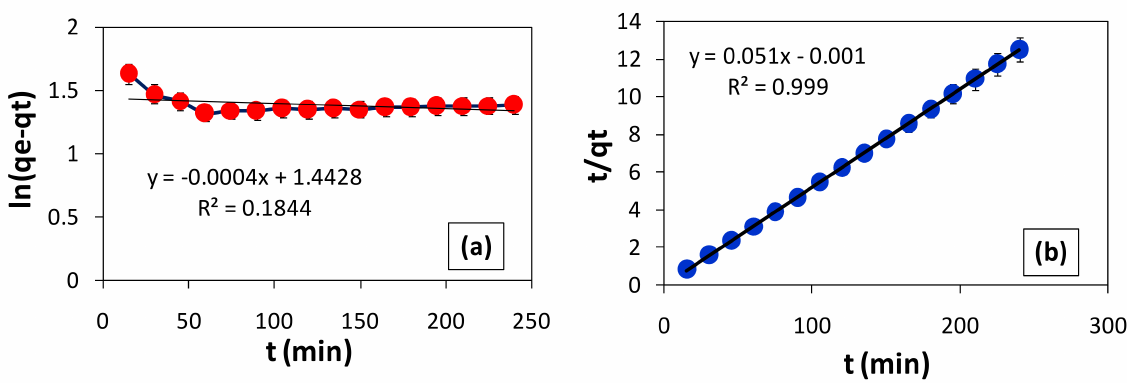
Figure 9. Kinetics of BG removal by F. benghalensis leaves powder. ( a ) Pseudo-1st-order; ( b ) pseudo- 2nd-order plots.